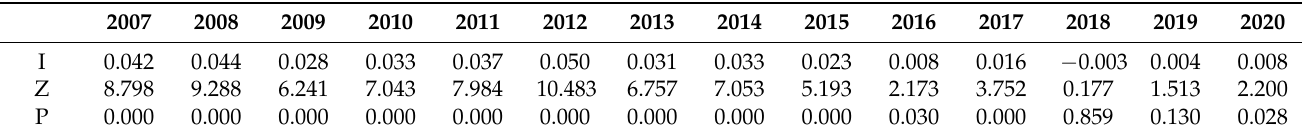
Table 4. Global Moran index of urban EWP in China from 2007 to